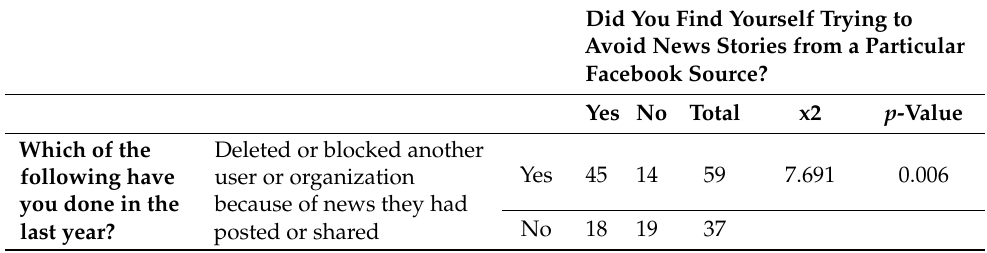
Table 8. Chi-square test analysis of actions and reactions in the last year on the Facebook platform.